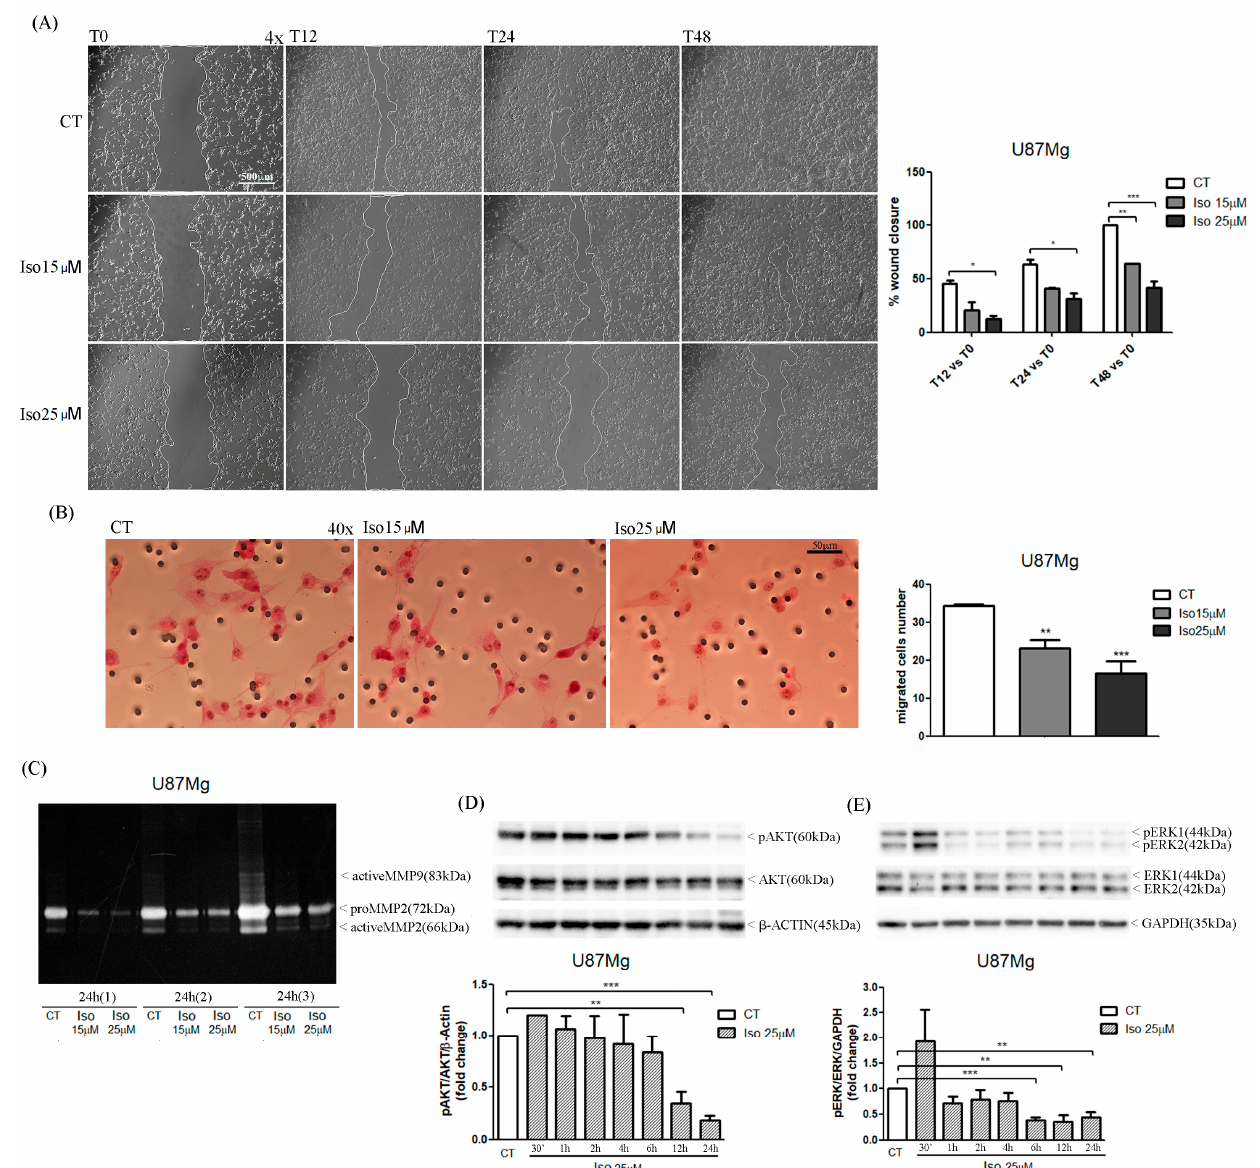
Figure 3. ( A ) Wound healing assay in U87MG treated with Iso 15 and 25 µ M: the closure of the scratch area in treated cells is less than in control cells, at all observed times (scale bar 500 µ m). ( B ) Migration assay in U87MG treated with Iso 15 and 25 µ M for 48 h: the number of migrated cells in the treated U87MG is lower than in the controls (scale bar 50 µ m). ( C ) Zymography assay in culture medium collected from U87MG after 24 h of induction with Iso 15 and 25 µ M: in treated cells isoginkgetin reduces the enzymatic activity of MMP9 (83 kDa), proMMP2 (72 kDa), and activeMMP2 (66 kDa) compared to control cells. ( D , E ) Western blot analysis of pAKT and pERK1/2 in U87MG after a short-term treatment with Iso 25 µ M: Isoginkgetin significantly reduces the levels of phosphorylated AKT only at 12 and 24 h oh treatment ( D ) and reduces the levels of phosphorylated ERK1/2 already at 6 h of treatment ( E ). Values are the means ± SEM of three individual experiments. Unpaired t-test, one-way ANOVA test, Bonferroni’s multiple comparison test, * p values < 0.05. According to GraphPad Prism, ** p value 0.001 to 0.01 (very significant), *** p value 0.0001 to 0.001 (extremely significant).